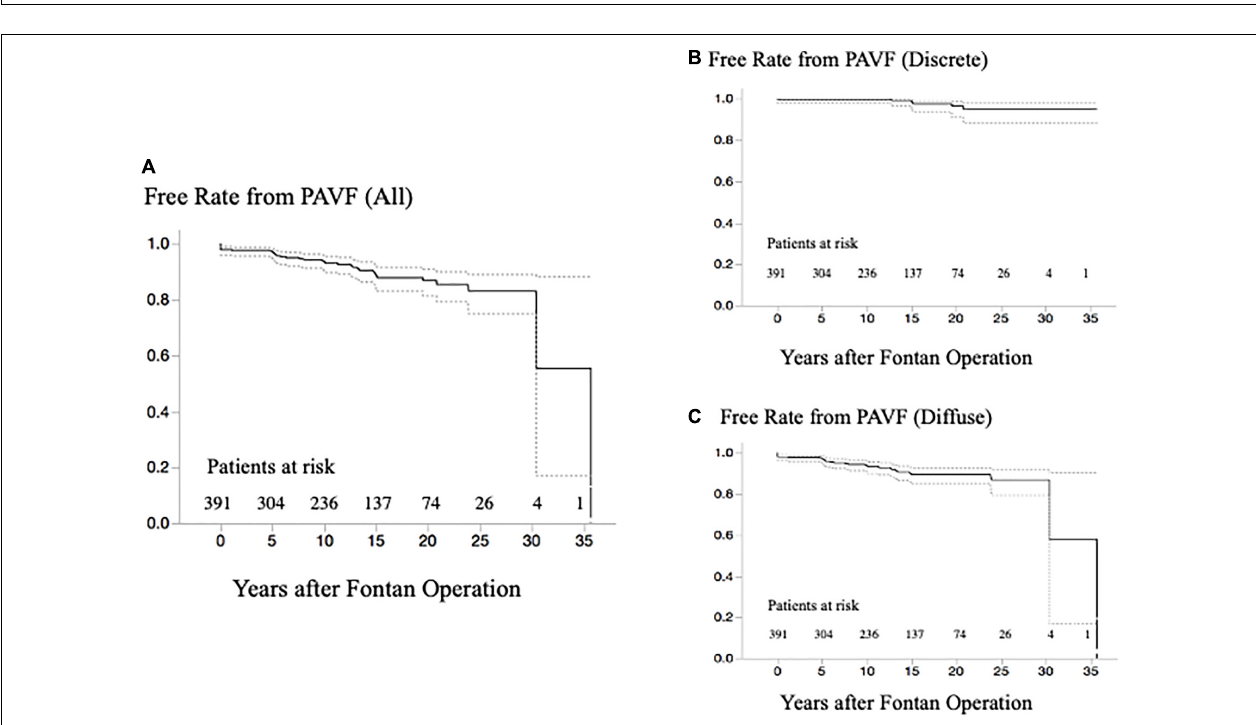
FIGURE 3 | (A) Free rate from any PAVF after the last evaluation of PAVF at catheterization. (B) Free rate from any discrete-PAVF after the last evaluation of PAVF at catheterization. (C) Free rate from any diffuse-PAVF after the last evaluation of PAVF at catheterization. PAVF, pulmonary arteriovenous fistulae.